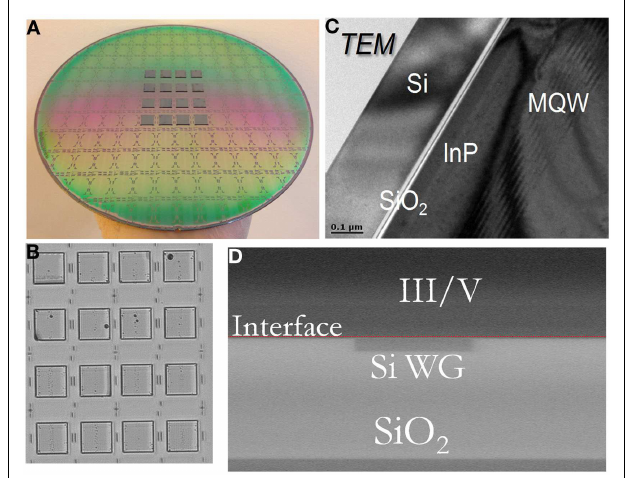
FIGURE 12 | (A) The optical image of the 16-dies bonded silicon wafer. (B) CSAM results. (C) TEM of the bonding structure. (D) Cross-SEM of the bonding structures.